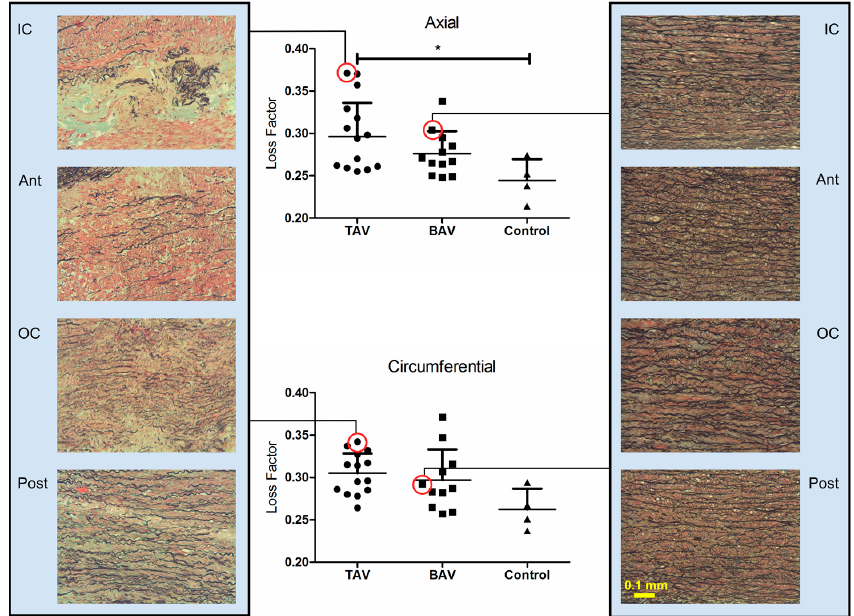
Figure 2. Average loss factor for the three tissue groups in the axial and circumferential directions. Average axial loss factor depends on groups ( p = 0.0419) (Kruskal-Wallis and Dunn’s multiple comparisons post-test). Asterisk shows significant difference: (*) p < 0.05. The figure also presents the histology images for the aortic quadrants of a 76-year-old patient from the TAV group and an 81-year-old patient from the BAV group.